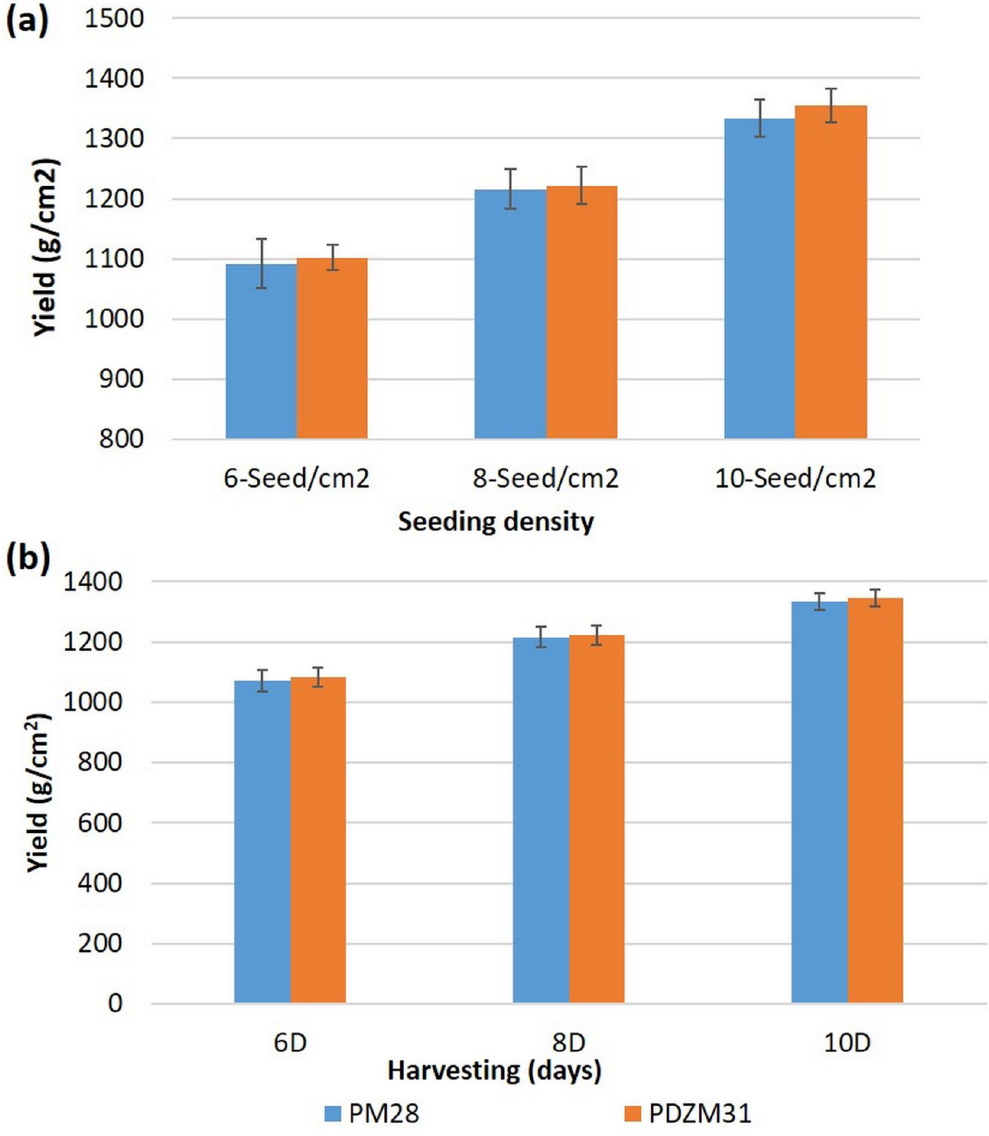
Fig 2. Microgreens yield of two Indian mustard genotypes (PM28 & PDZM31) (a) at a seeding density of 6, 8, and 10 seed/cm 2 on 8 th day after sowing and (b) at 6 th , 8 th , and 10 th day of sowing. Where ‘D’ is days after sowing and values are expressed as mean ± SD (n =